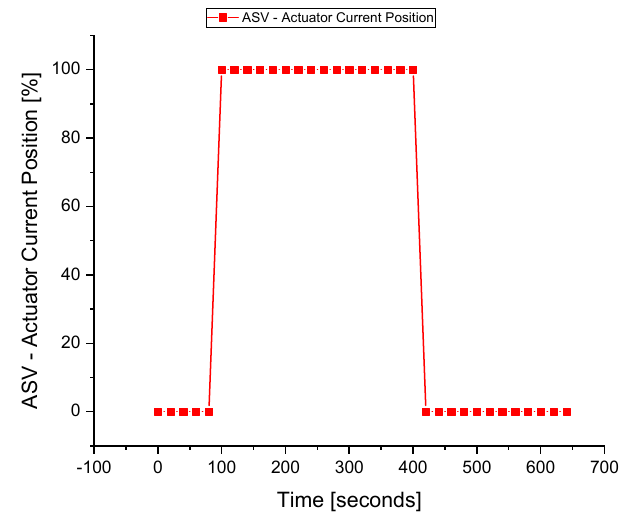
Figure 16. The actuator response during a fault in the T s sensor.